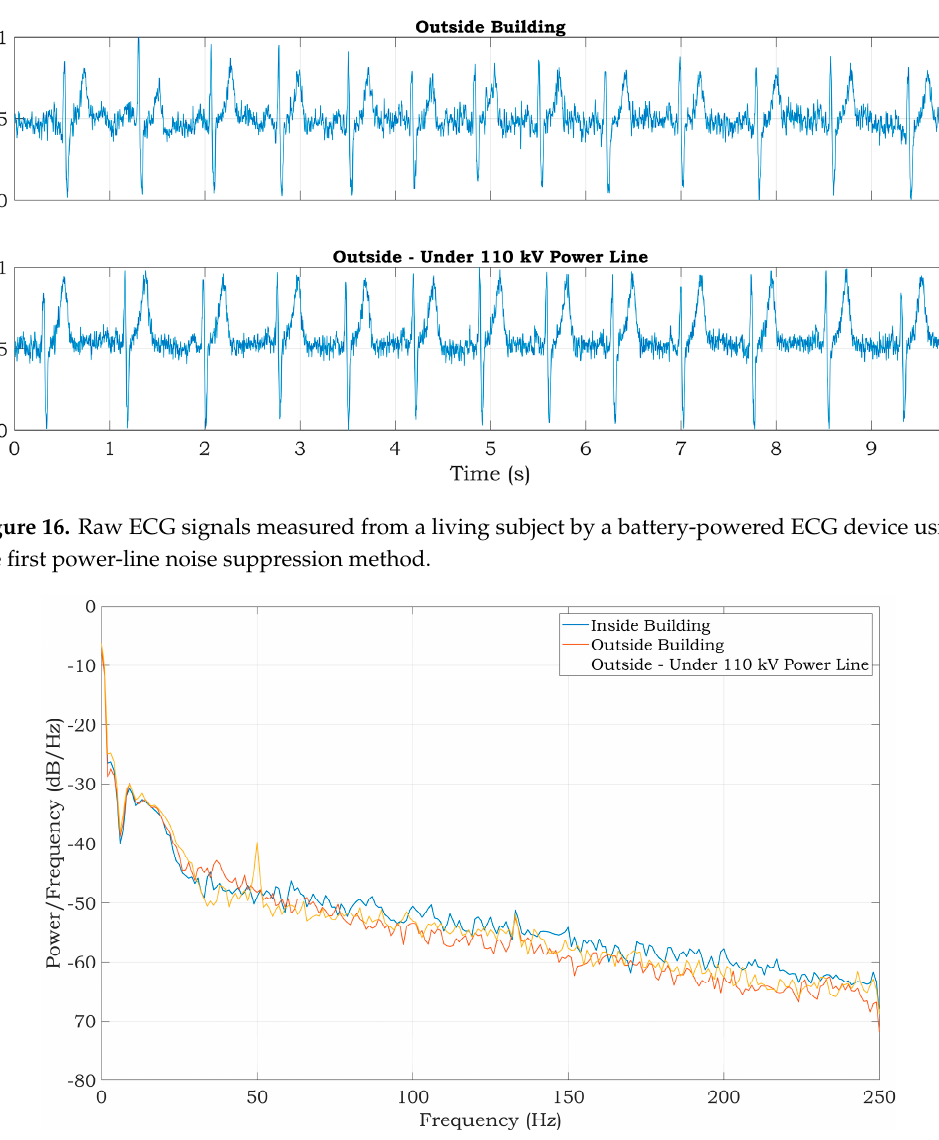
Figure 17. PSD estimates of raw ECG signals measured from a living subject by a battery-powered ECG device using the first power-line noise suppression method.